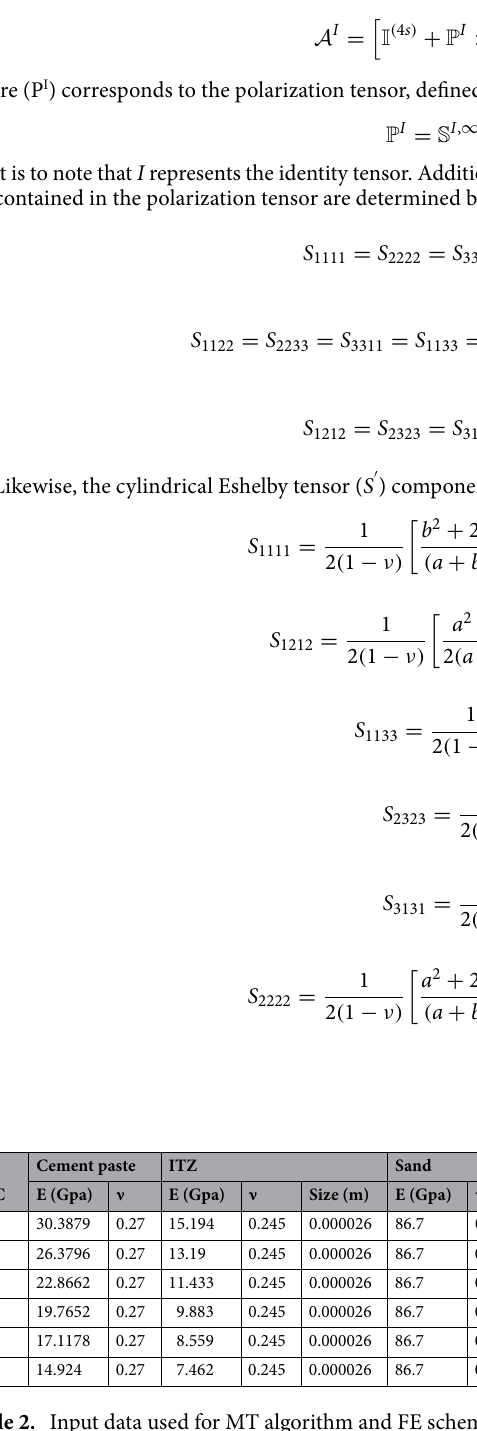
Table 2. Input data used for MT algorithm and FE